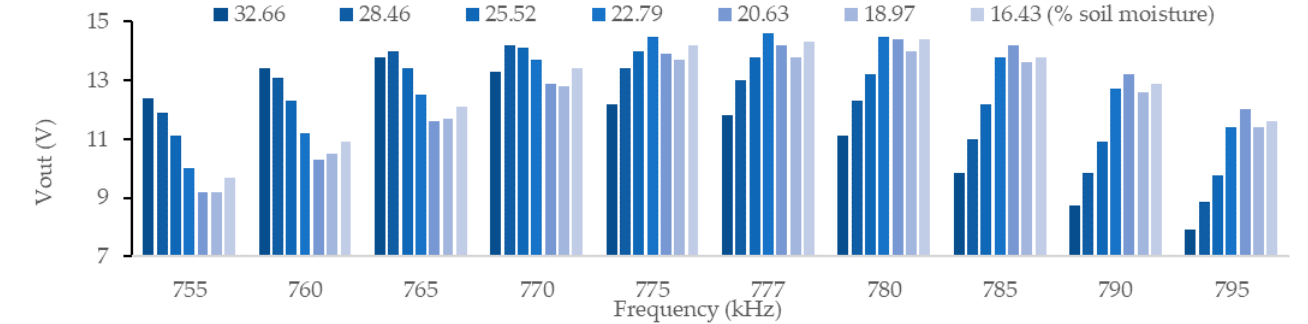
Figure 15. Vout of P8 using S5.